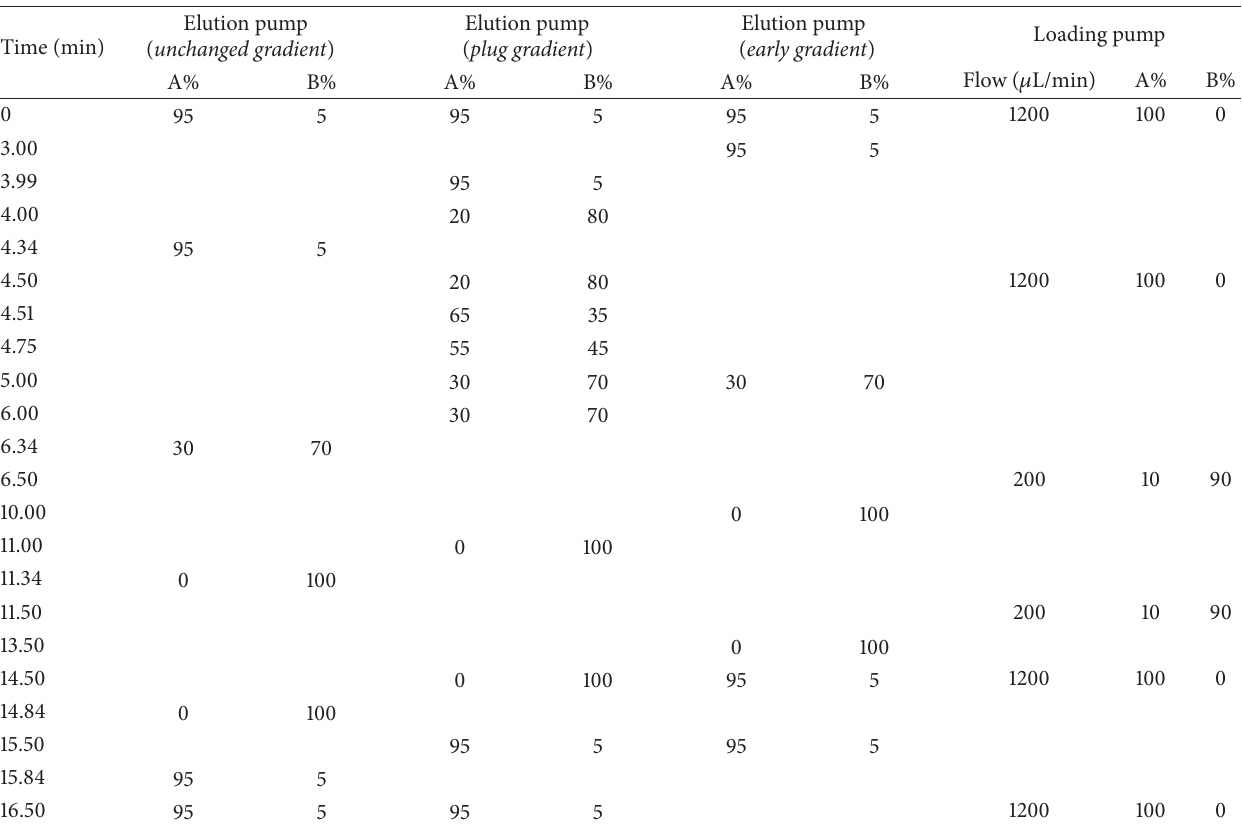
Table 1: Elution gradients used by the loading pump and the elution pump. Elution pump flowed at 300 𝜇 L/min. Loading time was 260 s. Sample volume was 5